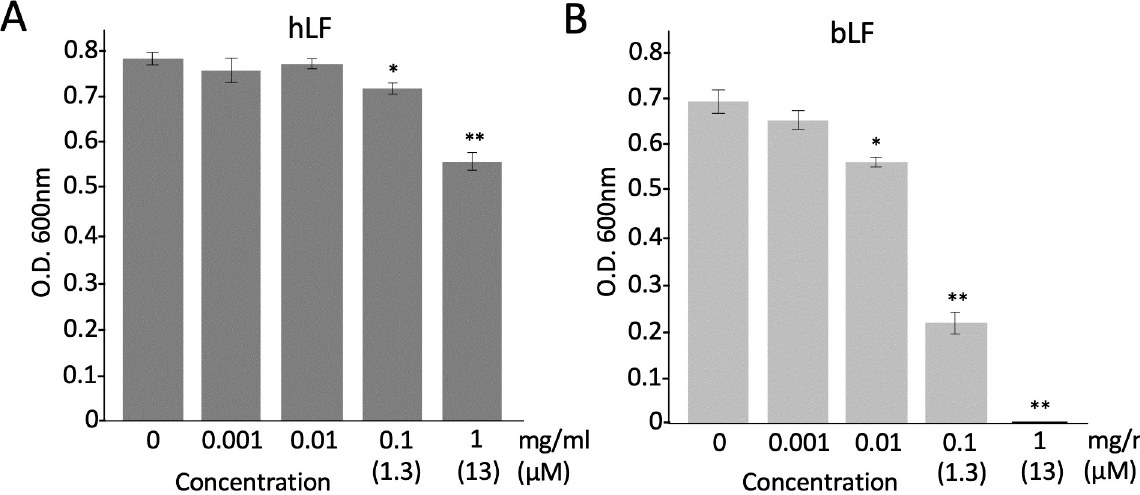
Fig 1. Comparison of the antimicrobial effects of human-derived lactoferrin (hLF) (A) and bovine-derived lactoferrin (bLF) (B) on Streptomyces scabiei S58. The mixture of lactoferrin and spores (2 × 10 5 /mL) was incubated at 28 ˚C for 72 h in tryptic soy broth and the absorbance was measured at 600 nm to monitor bacterial growth. Error bars indicate the mean ± standard division of three independent experiments. Asterisks show a significant difference with respect to the control at � p < 0.05 and �� p < 0.01 (Student’s t test).